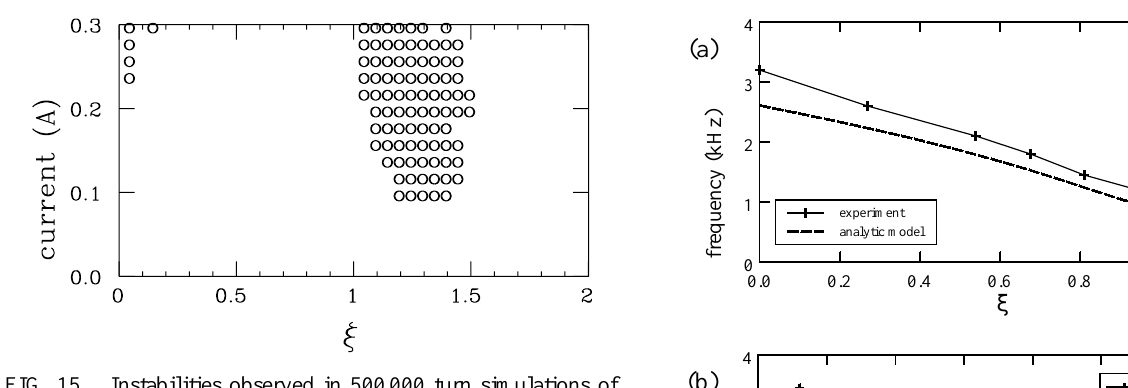
FIG. 15. Instabilities observed in 500 000 turn simulations of active Landau-cavity operation with the LF20 lattice and b 2 (cid:1) 160 , with an increased fundamental rf voltage of 90 kV.